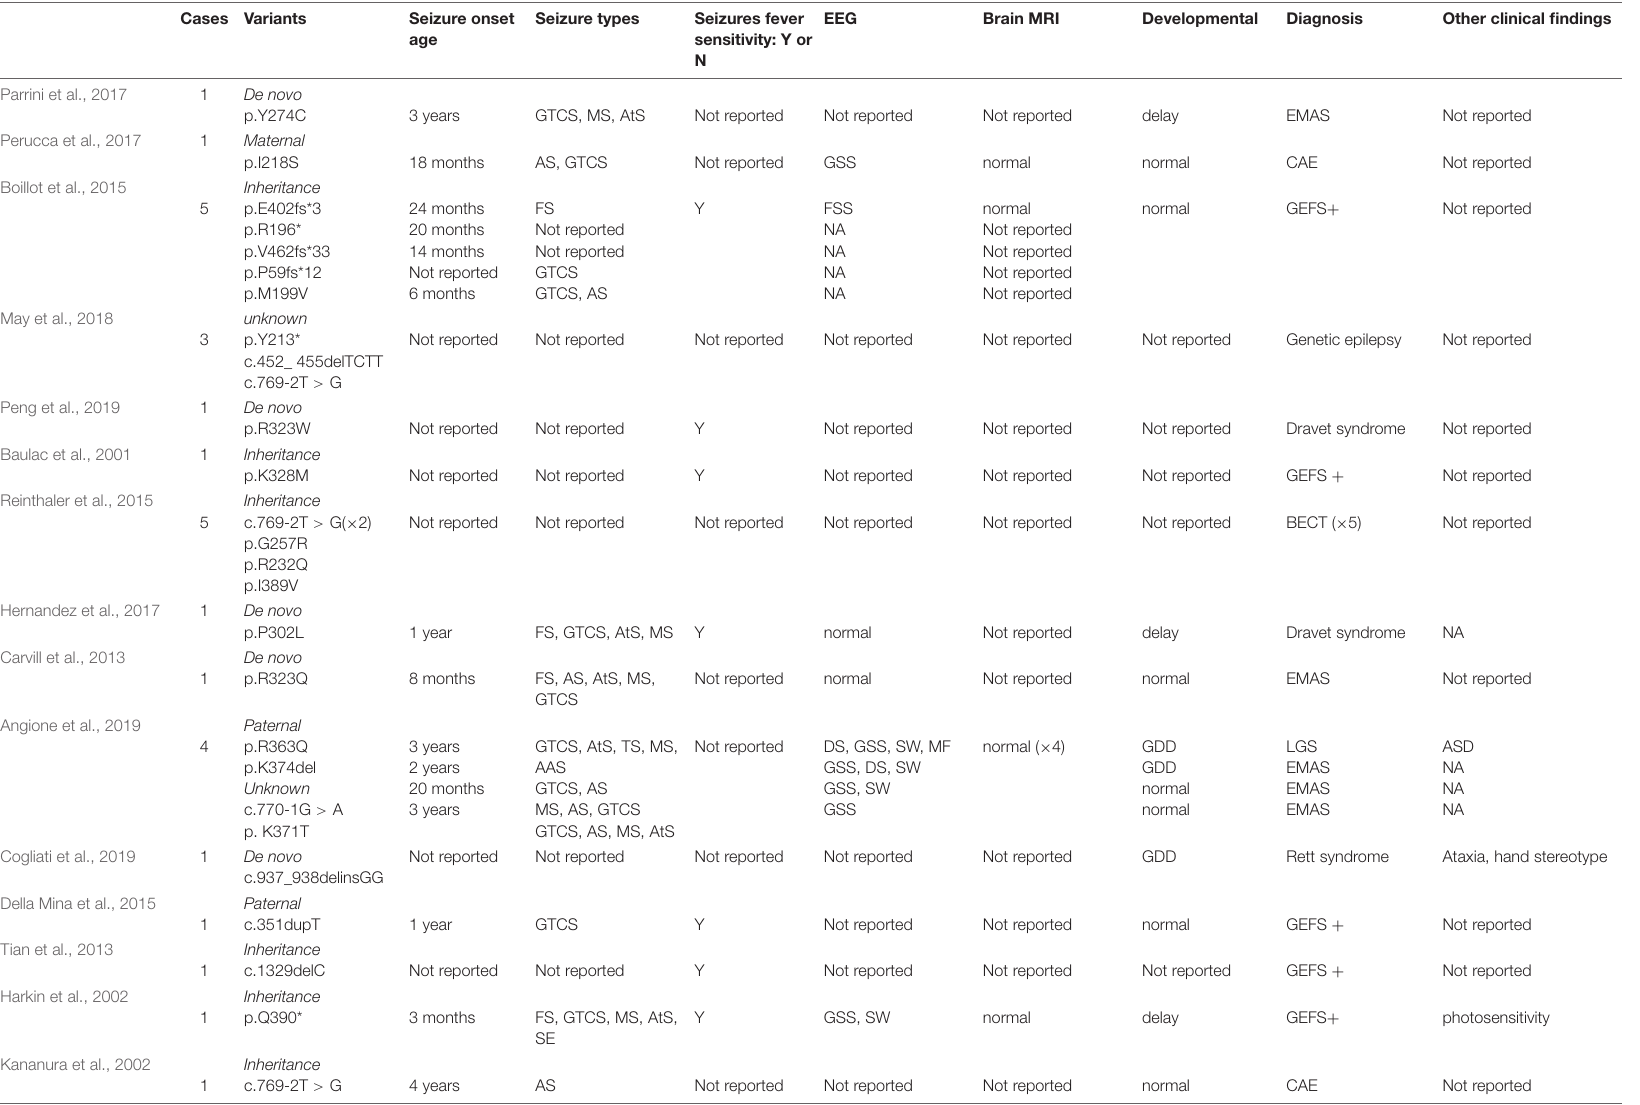
4 years AS Not reported Not reported Not reported normal CAE Not reported AAS, atypical absence seizure; ADHD, attention deficit and hyperactivity disorder; AS, absence seizure; ASD, autistic spectrum disorder; AtS, atonic seizure; CAE, childhood absence epilepsy; CS, clonic seizure; DS, diffuse slow waves; EMIFS, epilepsy of infancy with migrating focal seizures; EOEE, early-onset epileptic encephalopathy; GDD, global developmental delay; GSS, generalized seizures discharge; LGS, Lennox-Gastaut syndrome; EE, epileptic encephalopathy; EMAS, epilepsy with myoclonic atonic seizure; ES, epileptic spasms; FS, focal seizure; FSS, focal seizure discharge; FTS, focal tonic seizure; GTCS, generalized tonic-clonic seizure; SE, status epilepticus; MA, myoclonic atonic seizure; TS, tonic seizure; MS, myoclonic seizure; MF, multifocal; EEG, electroencephalography; SB, Suppression-burst; PSW, poly-spike wave; SW, spike wave; NA, not applicable. *Represents the nonsense